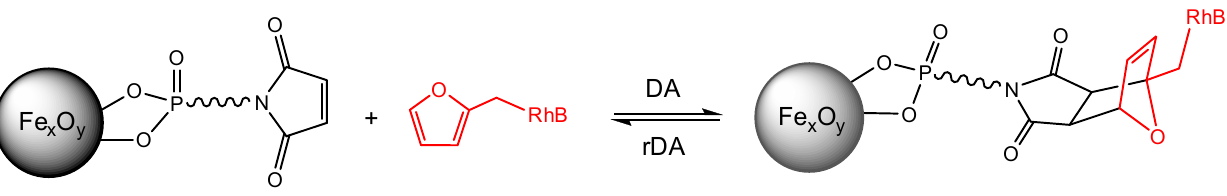
Figure 6. DA and retro-Diels–Alder (rDA) reaction on the surface of the iron oxide nanoparticles.